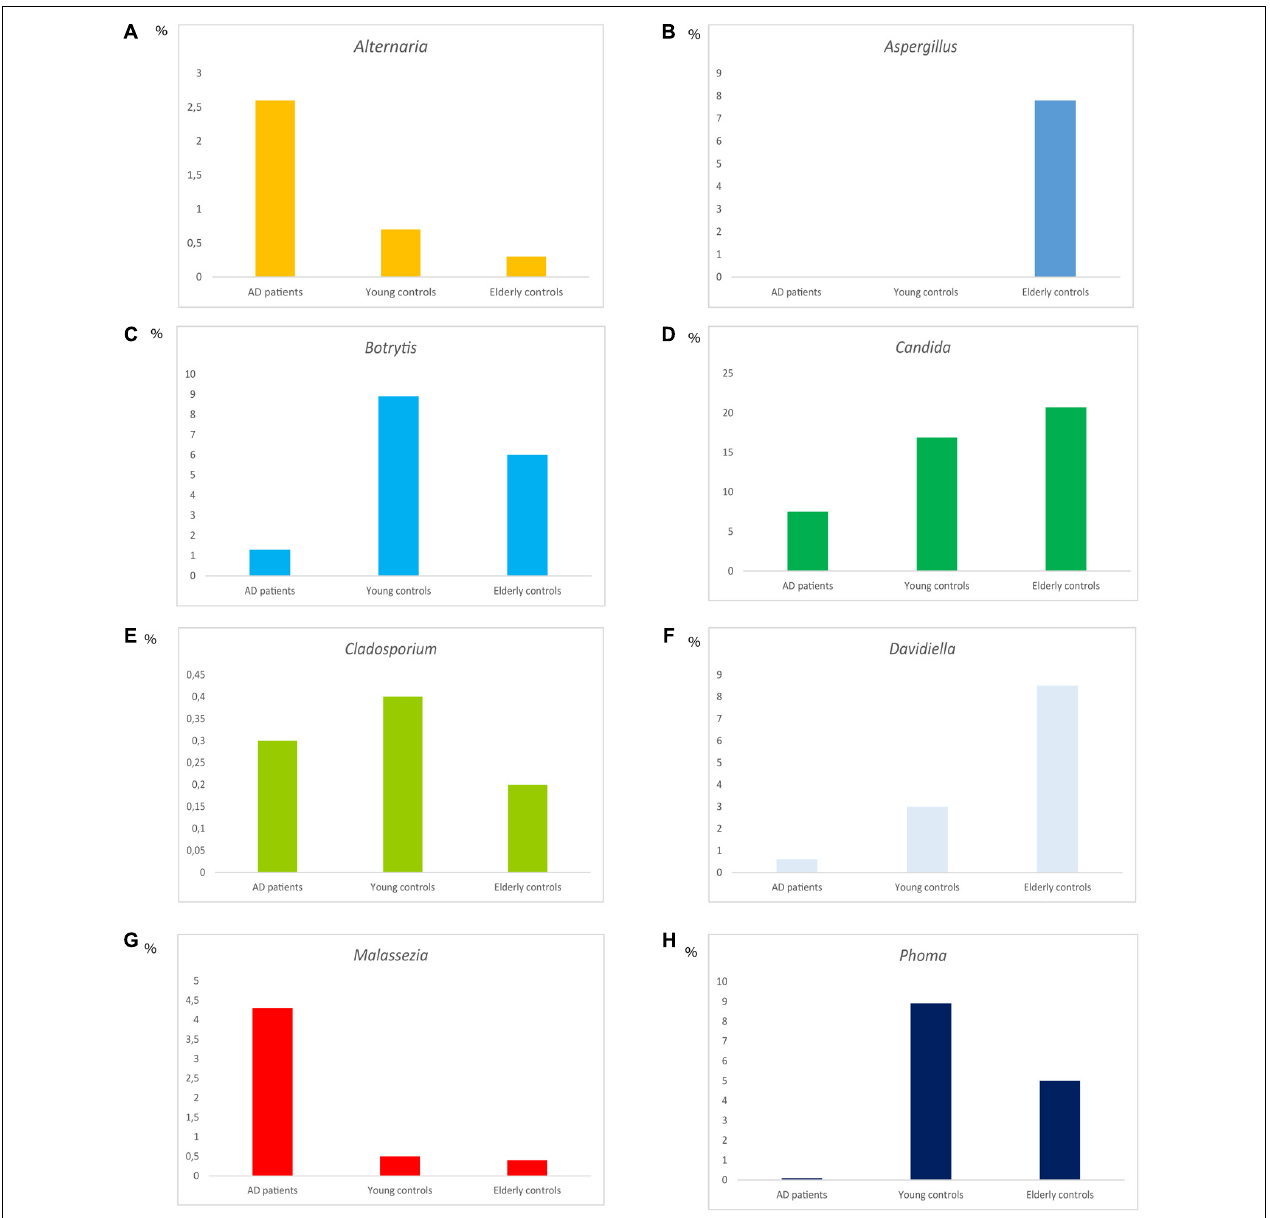
FIGURE 6 | Distribution of fungal genera between AD patients, elderly and younger controls. Median of the percentages of the different genera as indicated in the Figure (A–H)